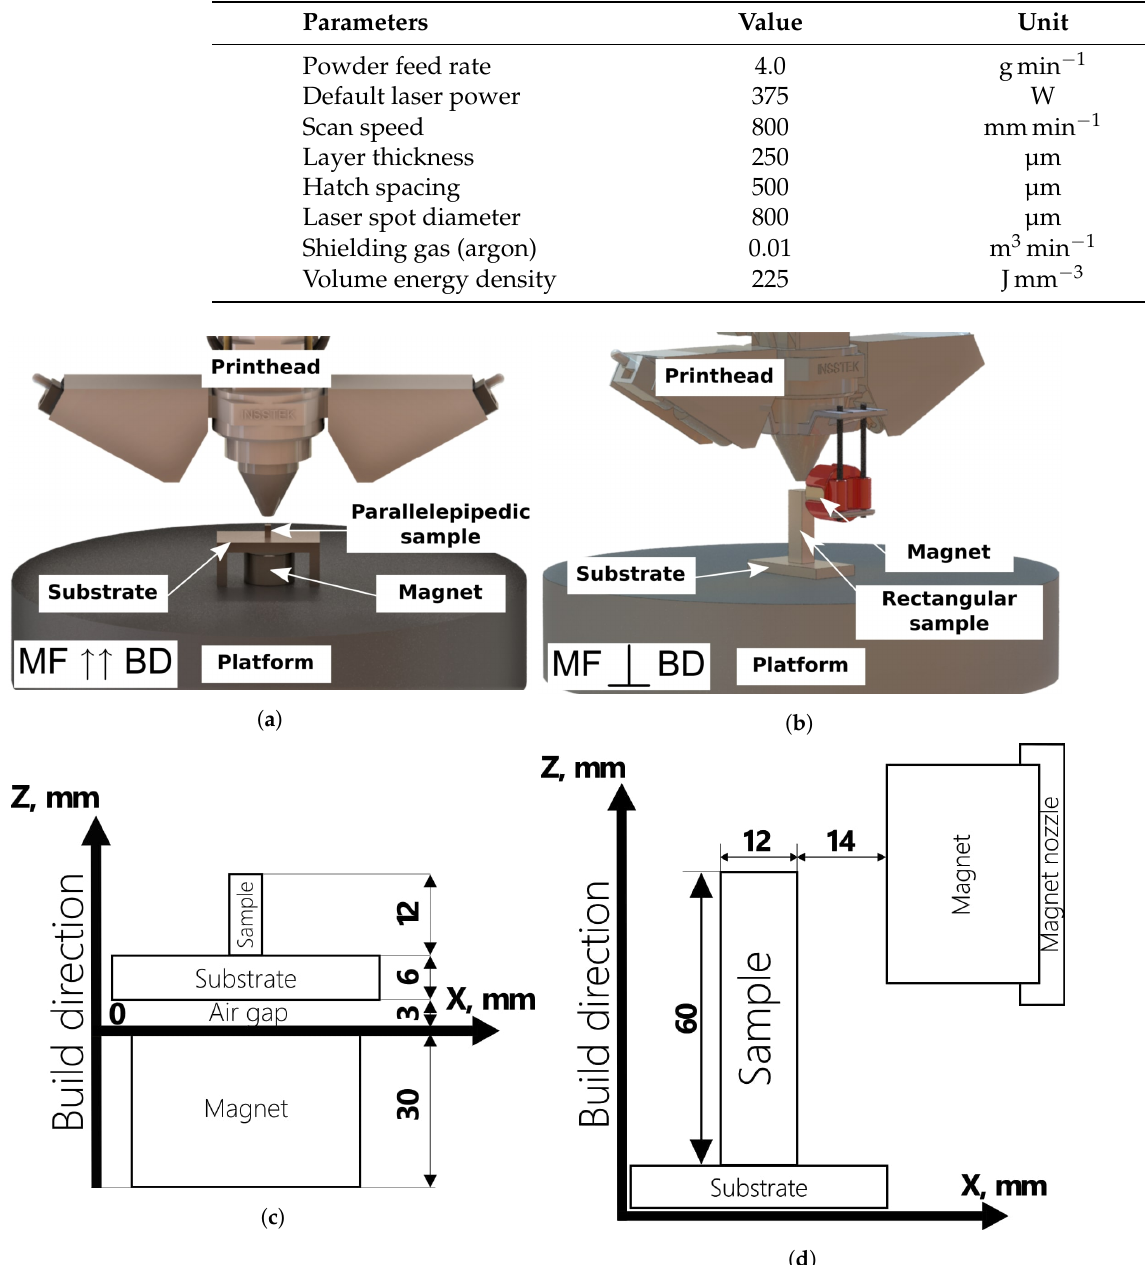
Figure 5. Experimental setups for 3D printing and their schematic illustrations for the case of vertical ( a , c ) and horizontal ( b , d ) MF